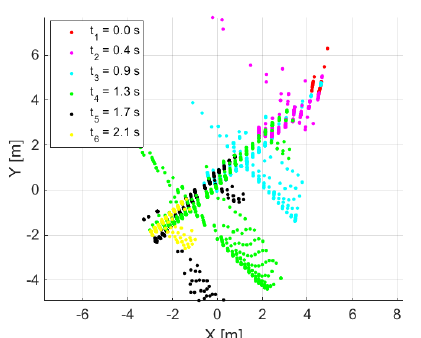
Figure 1. Scans of an aircraft, taken at different epochs (top view)